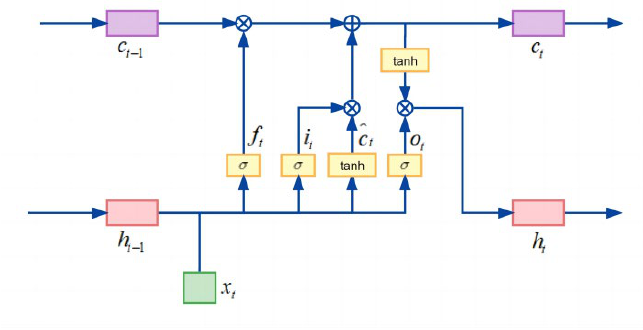
Figure 3. LSTM structure diagram.